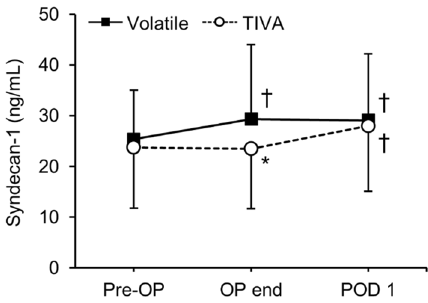
Figure 3. Perioperative changes in serum syndecan-1. OP, operation; POD, postoperative day; TIVA, total intravenous anesthesia. Values are expressed as mean ± SD. *Bonferroni-corrected P < 0.05 versus Volatile group. † Bonferroni-corrected P < 0.05 versus Pre-OP in each